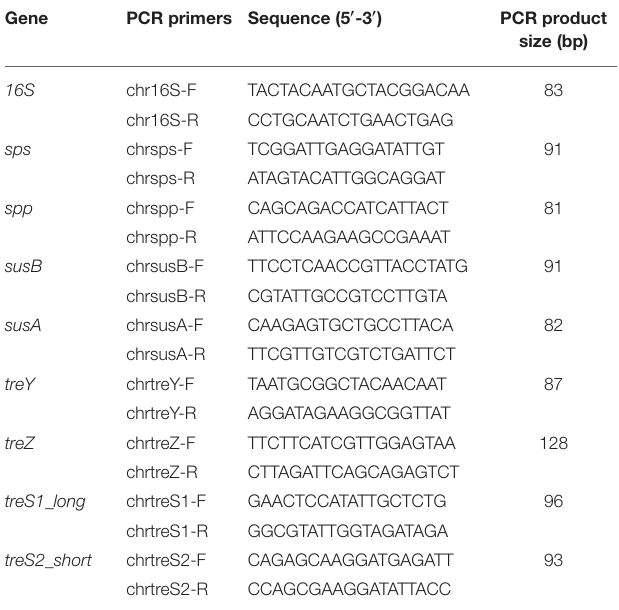
TABLE 1 | Primers used for